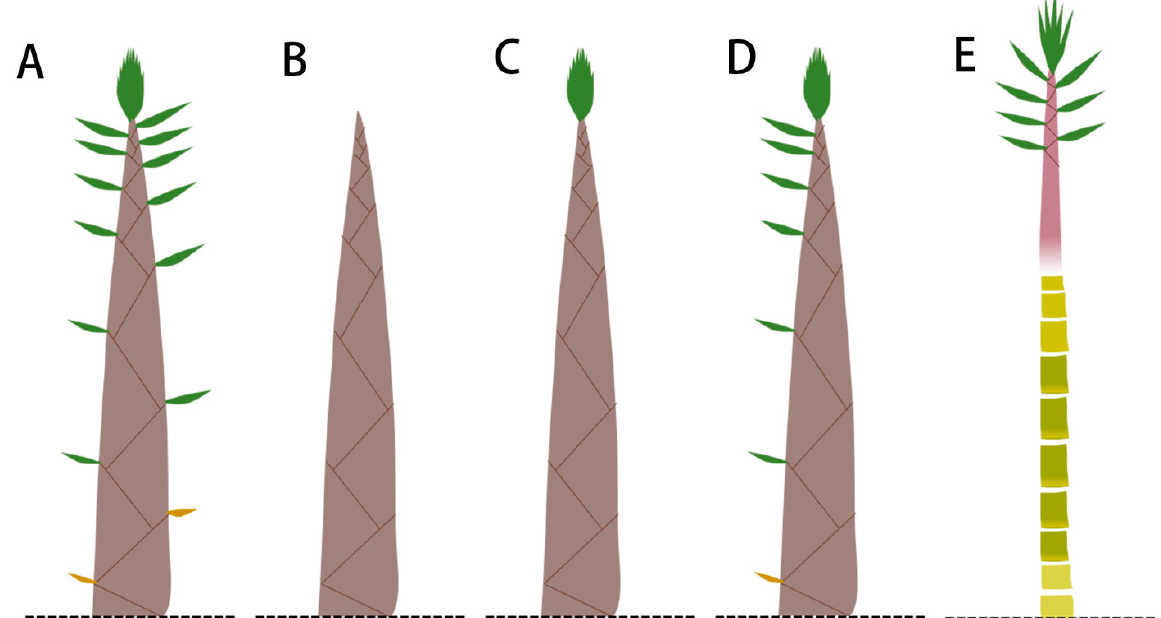
Figure 1. ( A ) No treatment was imposed, to serve as the experiment’s control. ( B ) Removal of all sheath blades. ( C ) Removal of all expanded sheath blades. ( D ) Removal of the sheath blades spread on one side only. ( E ) Removal of the entire intact bamboo sheath.